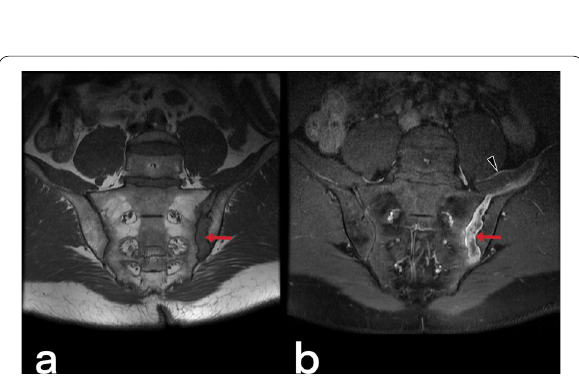
Fig. 48 MR images of a 43-year-old male. Pre-contrast T1 weighted ( a ) and post-contrast ( b ) T1 weighted images demonstrate contrast enhancement in the synovium of the left sacroiliac joint in keeping with acute sacroiliitis (arrows). Arrowhead shows an abscess formation in the left iliac muscle that enhances peripherally after contrast injection